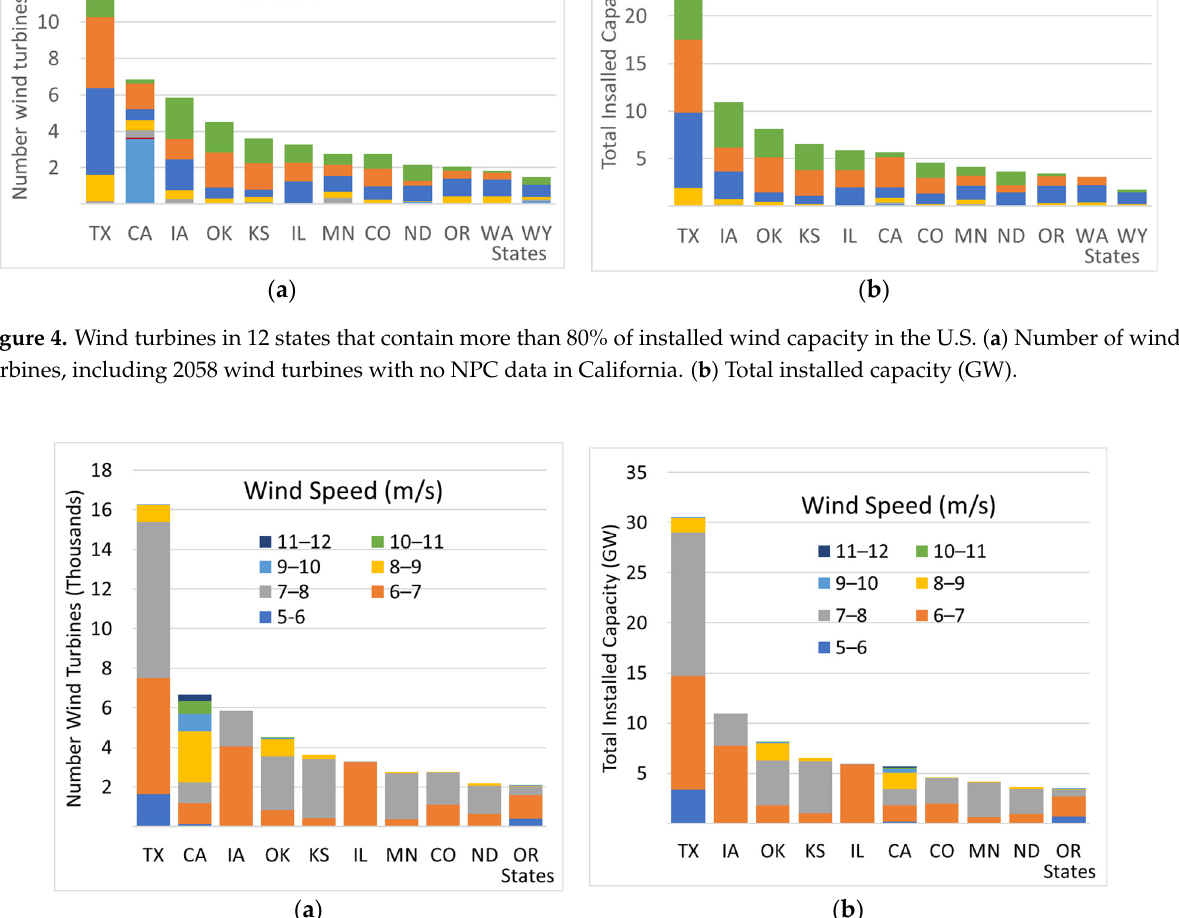
Figure 5. Evaluation of the average wind speed (m/s) at a 50 m height from the Global Wind Atlas 3.0 for each wind turbine per state: ( a ) number of wind turbines and ( b ) total installed capacity